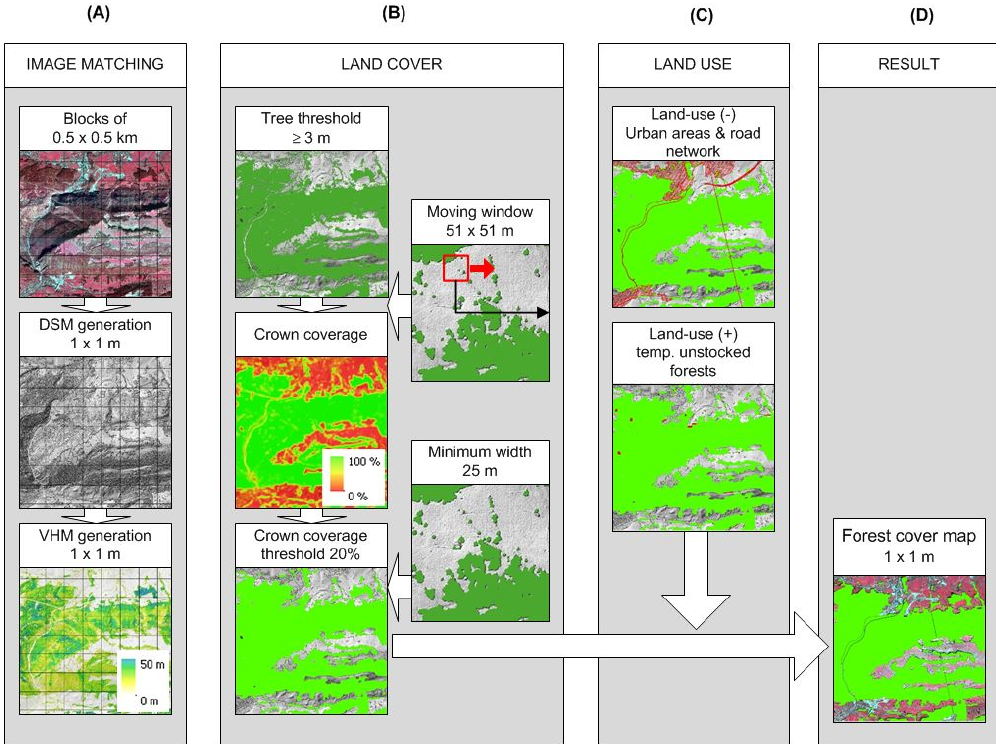
Figure 3. Workflow of the forest cover map implementing the existing Swiss NFI forest definition: ( A ) image matching; ( B ) preliminary forest cover map based on the land cover and the thresholds and parameter of the NFI forest definition (minimum tree height, crown coverage, and width); ( C ) removal of forest on other land and adding temporarily unstocked forests; and ( D ) final forest cover map.